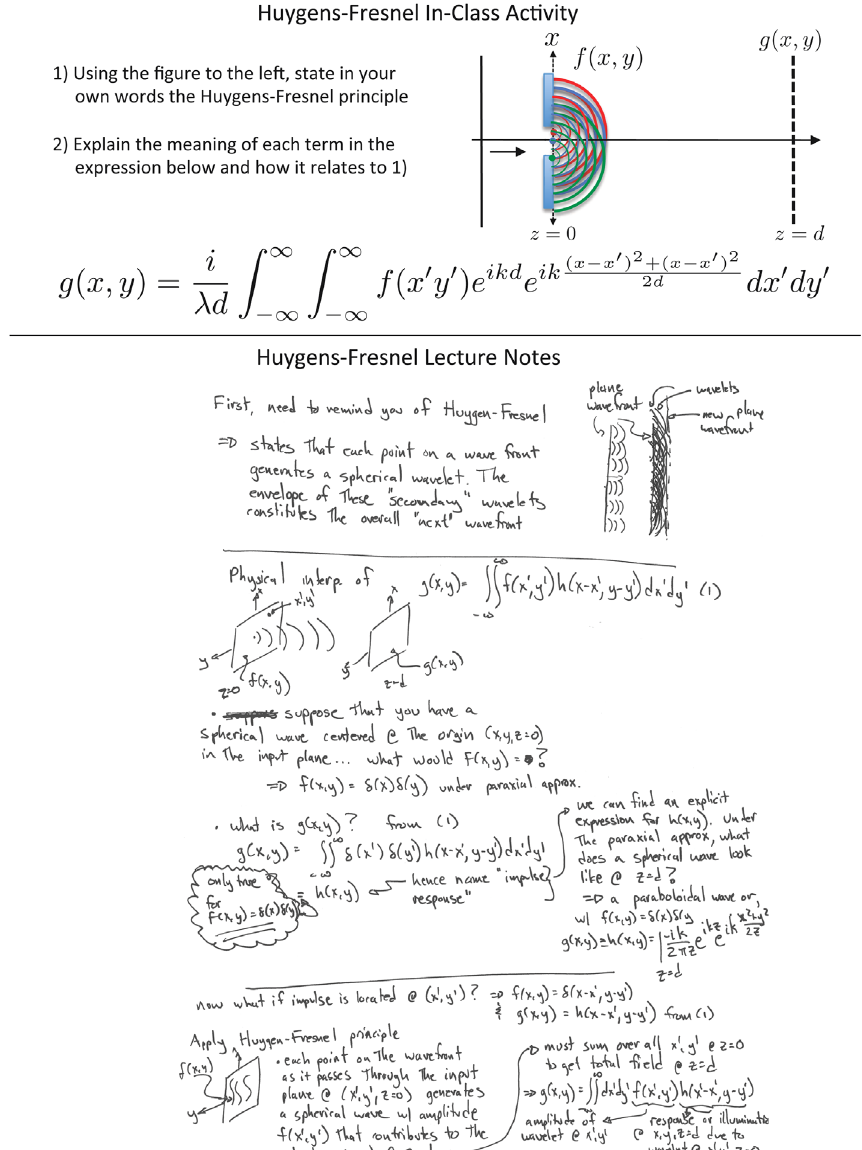
FIG. 4. An in-class activity on the Huygens-Fresnel principle and the corresponding lecture